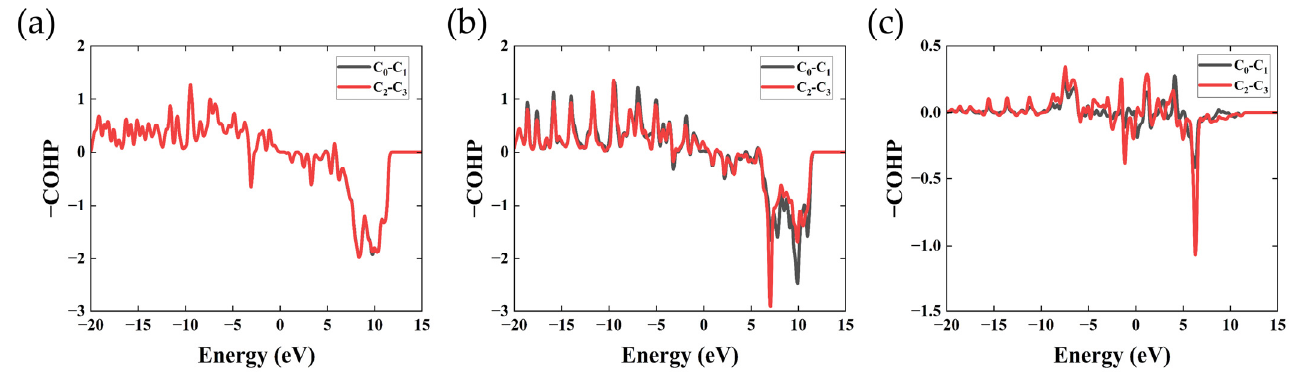
Figure 6. COHP analysis of C 0 -C 1 and C 2 -C 3 bonds of at ( a ) 0 K, ( b ) 300 K, and ( c ) 600 K.